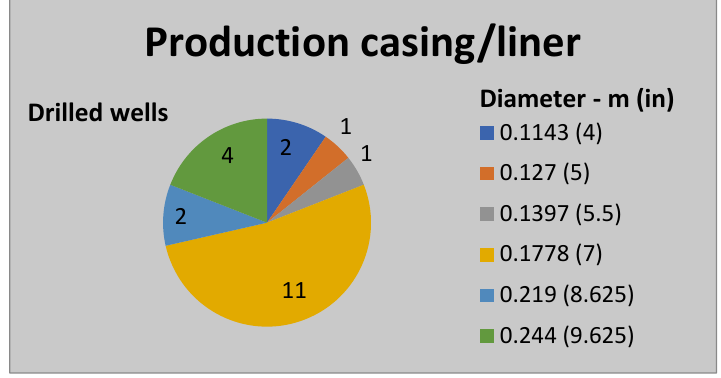
Figure 11. Diameter of intermediate casing II in 8 analyzed wells.